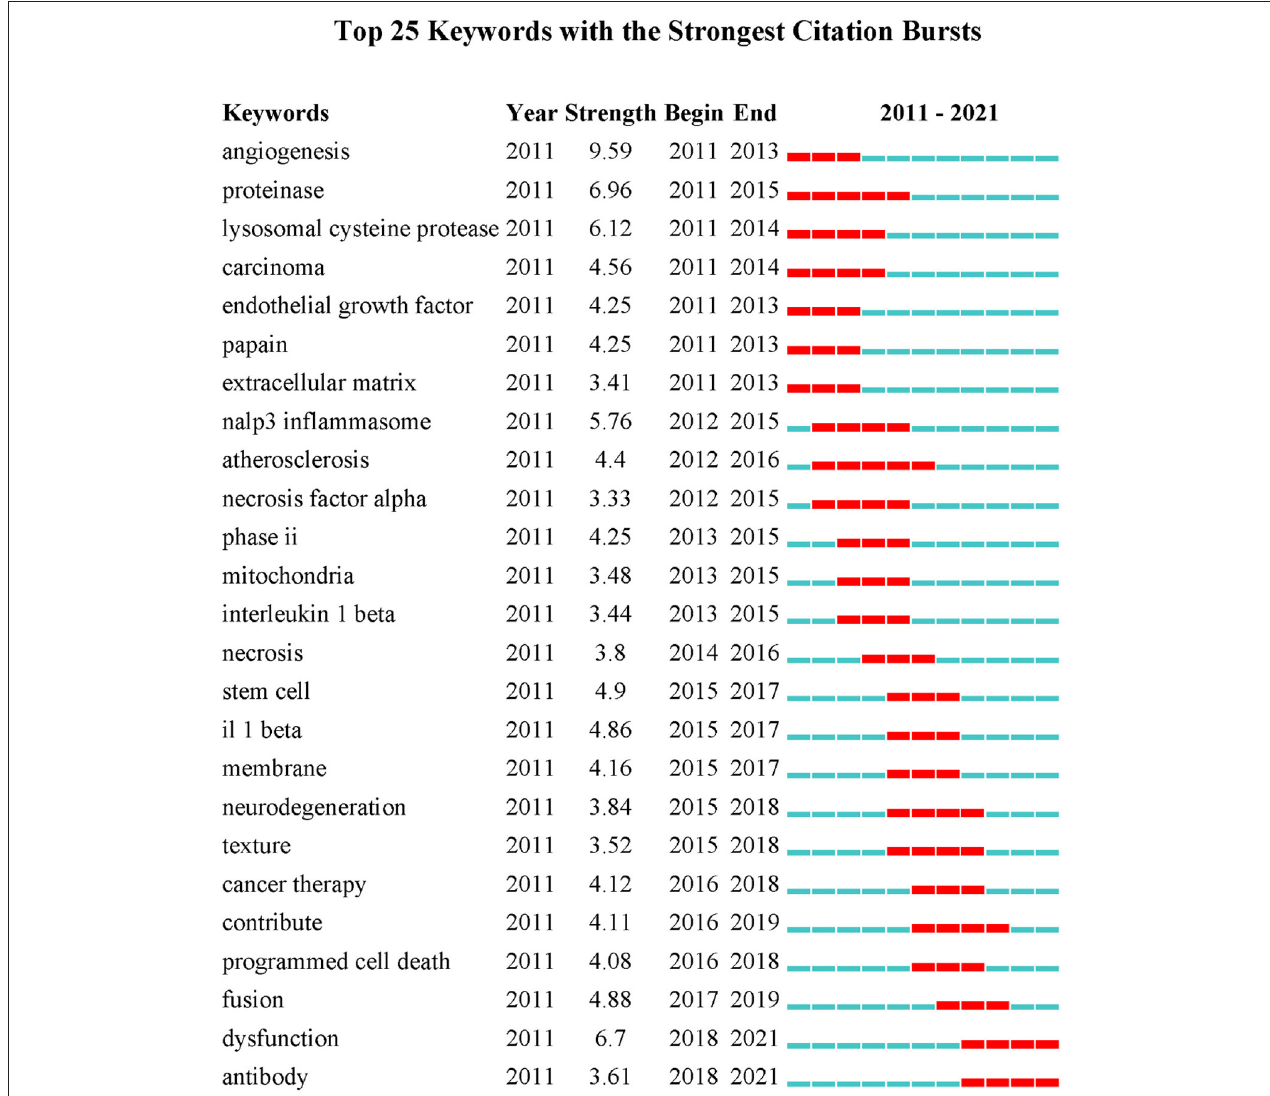
FIGURE 6 | Keywords with the strongest currently ongoing citation bursts (sorted in descending order of Begin).